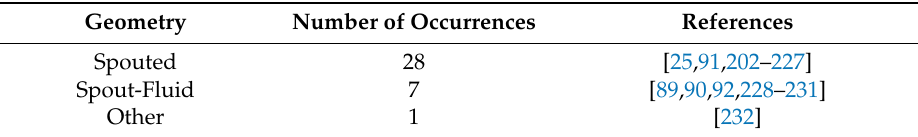
Table 7. Works on CFD-TFM modelling of SB.